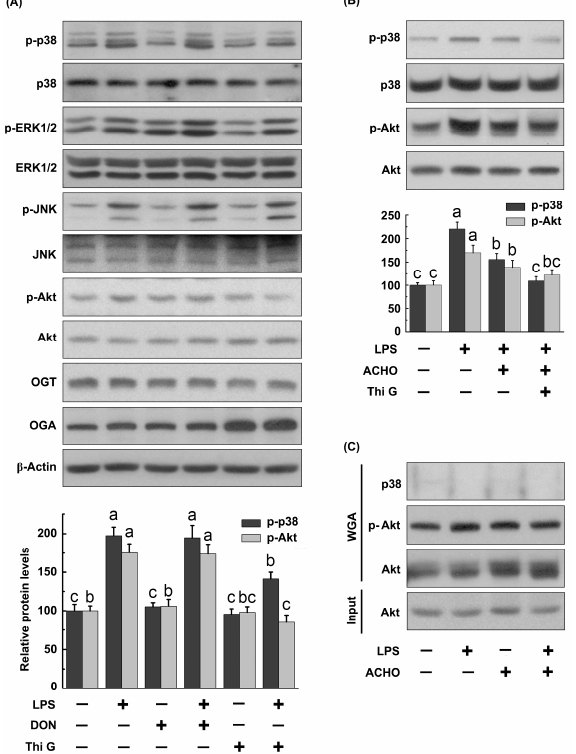
Figure 5. Suppression of MAPK and Akt phosphorylation by protein O -GlcNAcylation in LPS-induced macrophage cells. ( A , B ) RAW264.7 cells were pretreated with Thi G (50 nM), 6-diazo-5-oxo- L -norleucine (DON) (5 μ M) or ACHO (100 μ g/mL) in FBS-free medium for 12 h and then exposed to LPS (200 ng/mL) for 30 min. After that, cells were collected, and the protein samples were analyzed by western blot; ( C ) RAW264.7 cells were pretreated with ACHO (100 μ g/mL) in FBS-free medium for 12 h and then exposed to LPS (200 ng/mL) for 30 min. Then, the O -GlcNAcylated proteins were pulled down by WGA-agarose and captured using the antibodies against p38, Akt or p-Akt. Data represent the mean ± SD ( n = 3). Data with different superscript letters are significantly different ( p < 0.05).